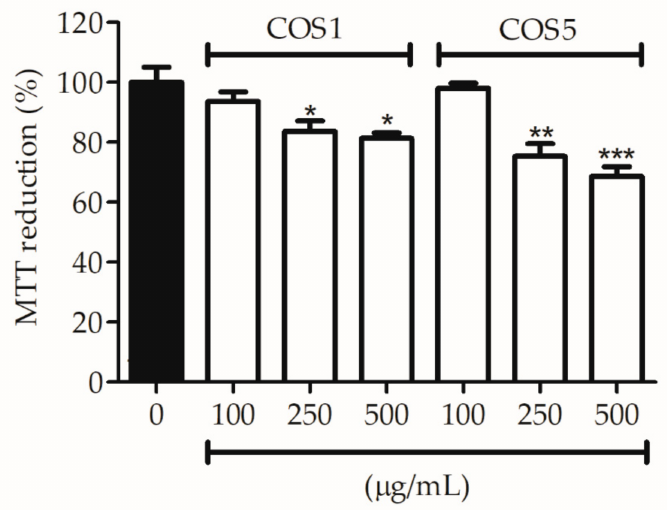
Figure 4. Cell viability of 3T3 fibroblasts incubated with COS1 and COS5 at different concentrations after 24 h of incubation. Note: * p < 0.05, ** p < 0.003, and *** p < 0.001 compared to the control group (bar